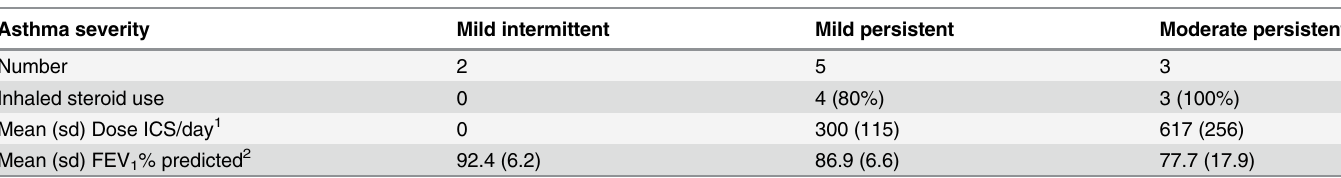
Table 2. Characteristics of subjects with